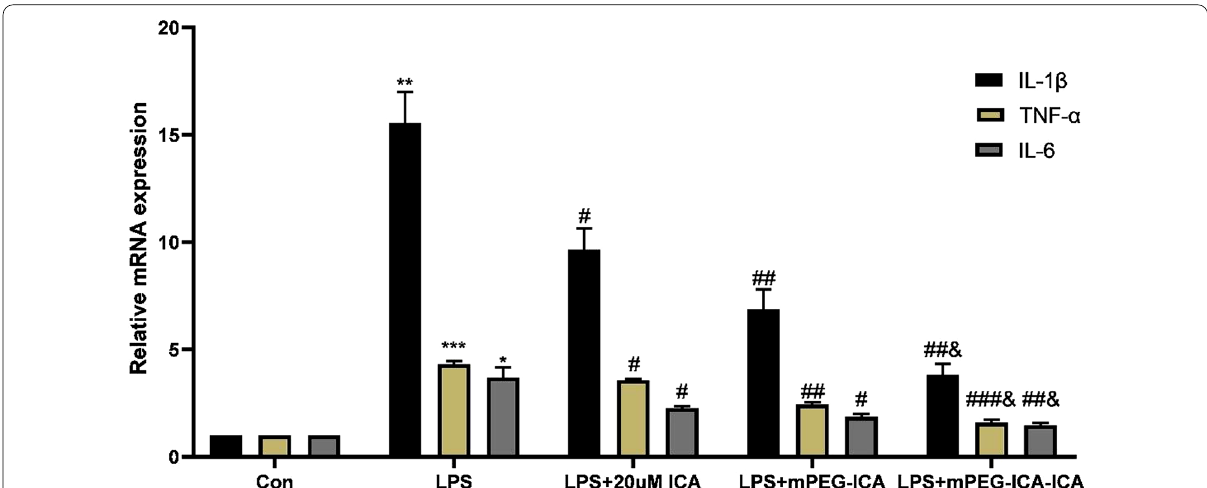
Fig. 11 Effects of ICA-loaded mPEG-ICA NPs on the mRNA expression levels of IL-1β, TNF-α and IL-6 in LPS-induced H9c2 cells. Effects of ICA-loaded mPEG-ICA NPs on the mRNA IL-1β in the LPS induced H9c2 cells. (** P < 0.01 compared with con; # P < 0.05 compared with LPS; & P < 0.05 compared with LPS mPEG-ICA.) (2) Effects of ICA-loaded mPEG-ICA NPs on the mRNA TNF-α. (*** P < 0.005 vs. con; # P < 0.05 vs. LPS group; & P < 0.05 vs. + LPS mPEG-ICA) (3) Effects of ICA-loaded mPEG-ICA NPs on mRNA IL-6. Data are the mean + LPS +